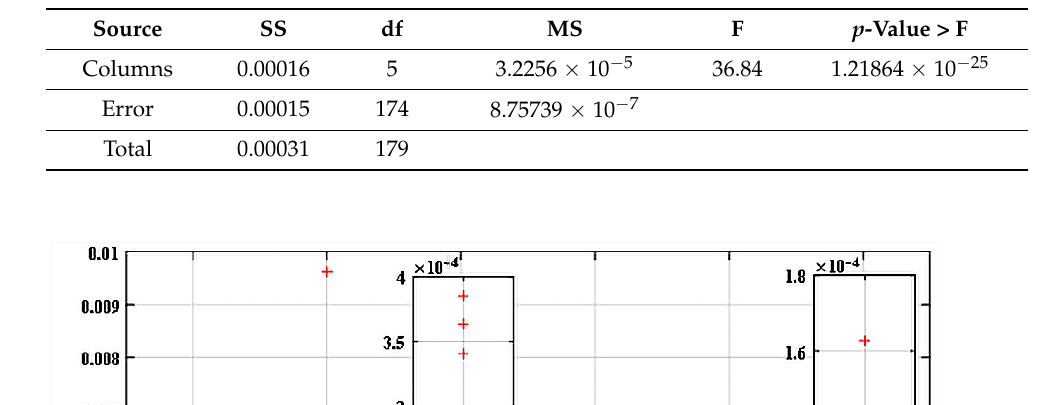
Table 4. ANOVA Results.